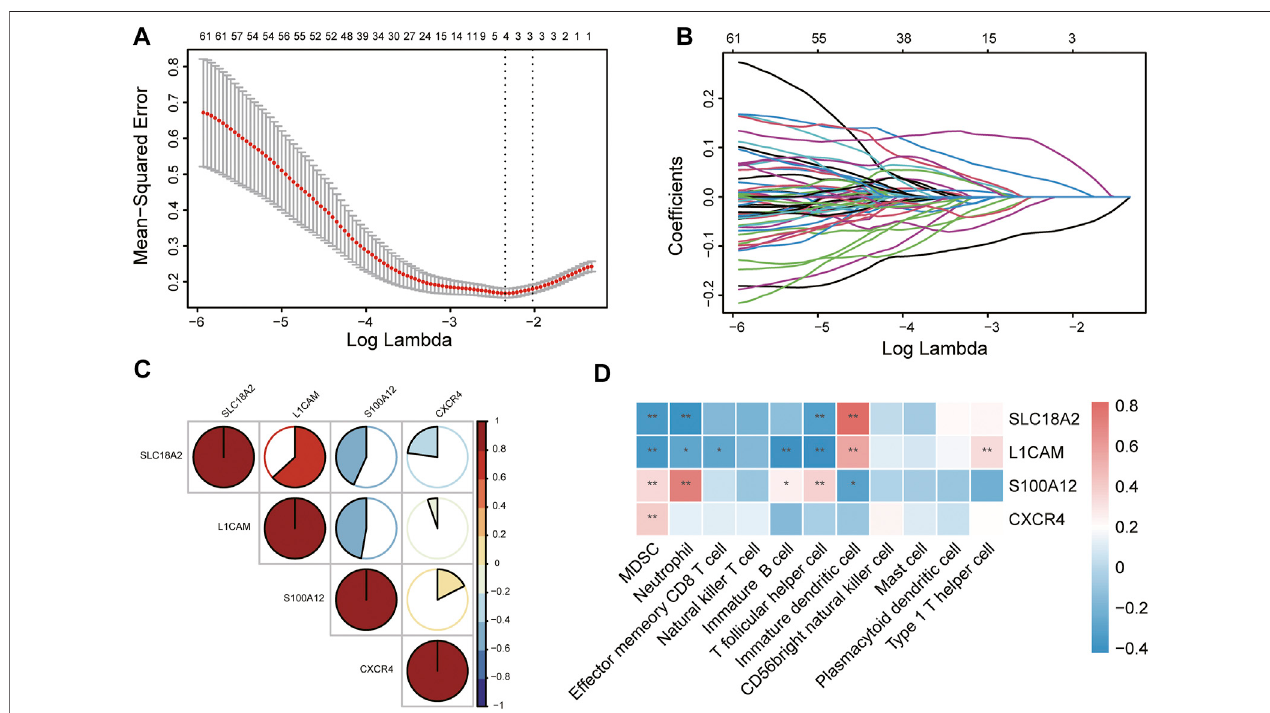
FIGURE 6 | Identi fi cation of immune-related hub genes via LASSO model. (A) Tuning parameter (lambda) selection in the LASSO regression model. The vertical linesweredrawnattheoptimalvaluesbyminimumcriteriaand1-SEcriteria,andweselectedminimumcriteriatoconstructthemodel. (B) TheLASSOcoef fi cientpro fi les. (C) The relationship among immune-related hub genes. (D) The relationship between immune-related hub genes and immune cells. * p < 0.05, ** p < 0.01.